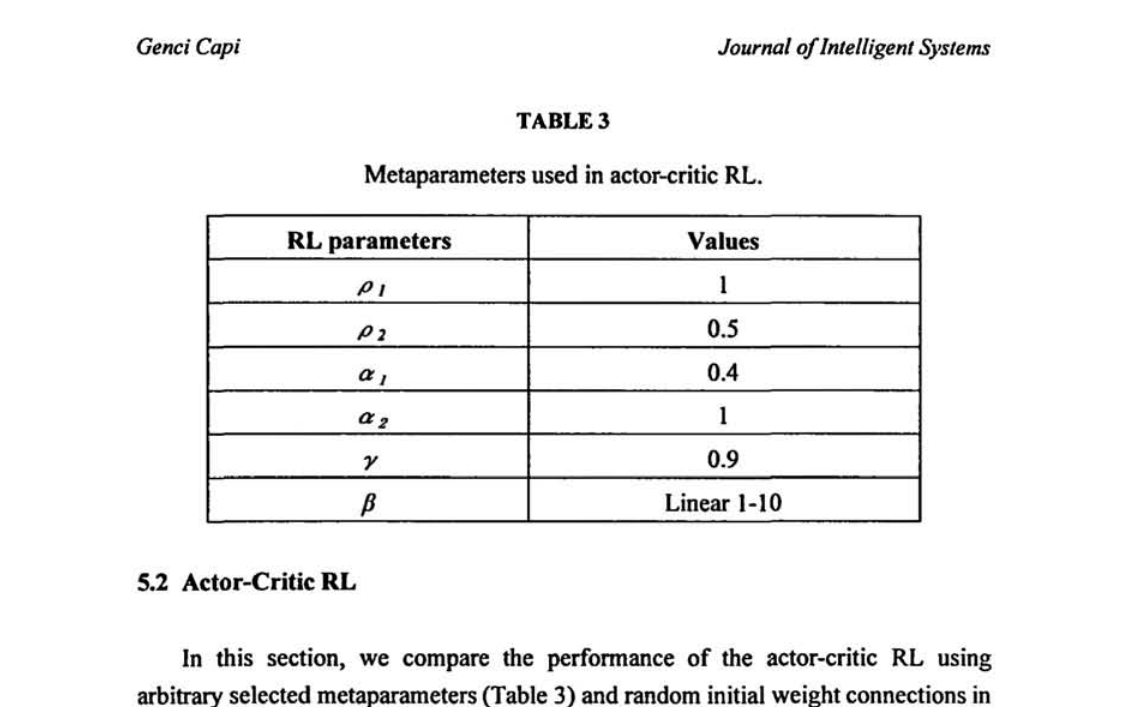
Metaparameters used in actor-critic RL.